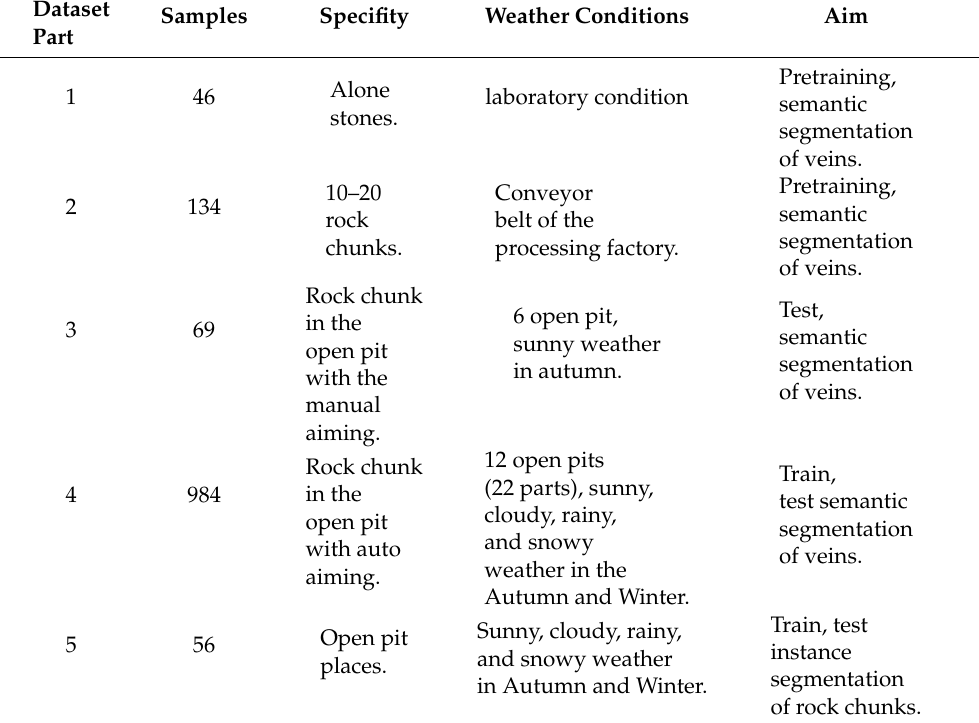
Table 1. Datasets